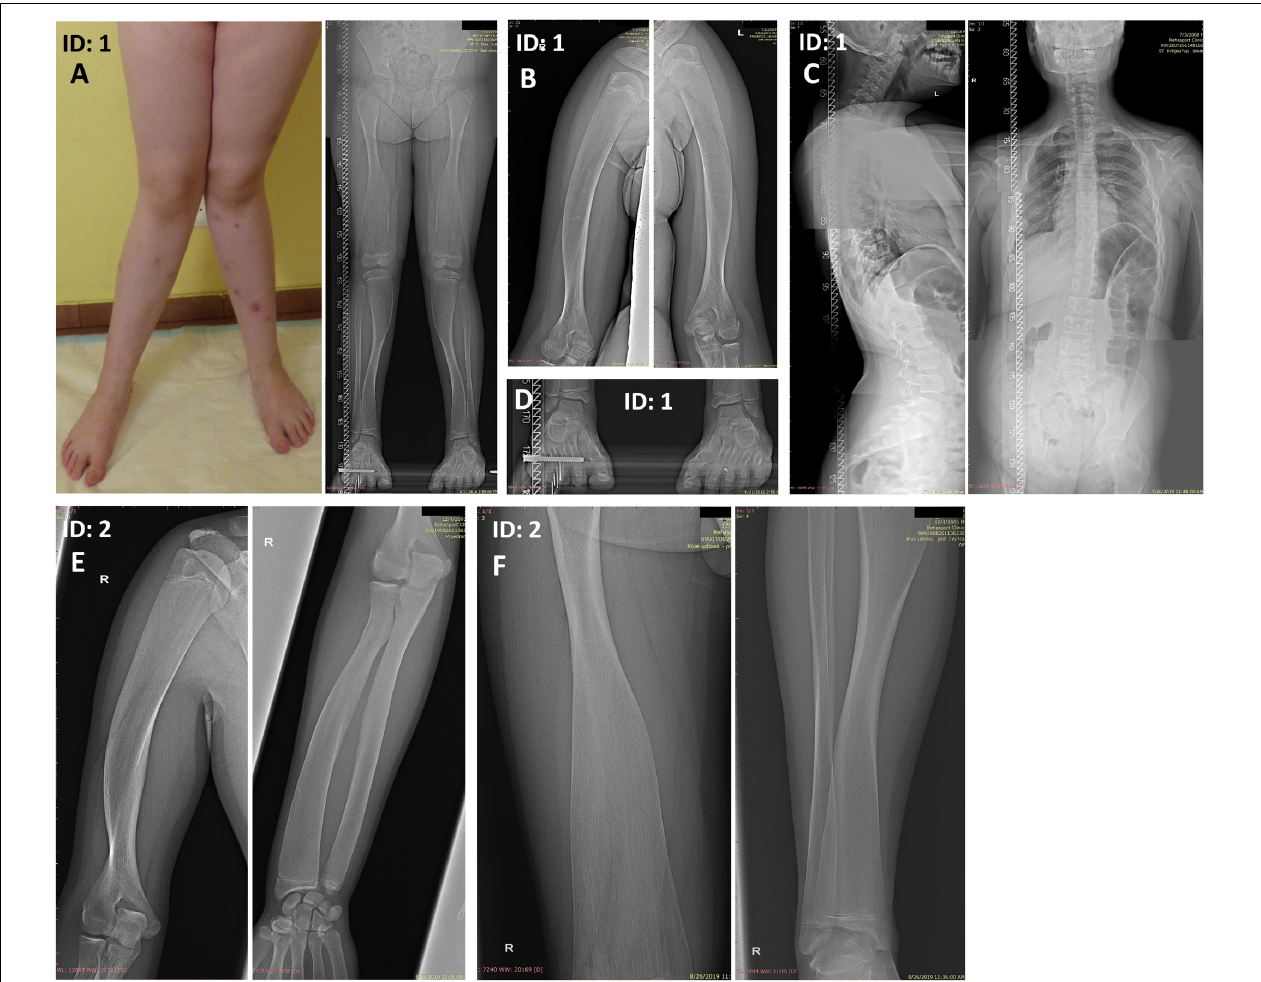
FIGURE 1 | Skeletal malformations observed in the female proband (A–D) and her brother (E,F) . (A) bilateral genua valga with a severe broadening of the knee joints. (A,F) Radiographs of the legs showing wide metaphyses and thin cortex of the femoral and tibial bones. (B,E) Radiographs of the upper extremities showing broadening of the proximal two-thirds of the humeri and the distal portion of the radial bone. The inward deviation of the distal one-third of the humeri was also noted (E) . (C) Radiographs of the spine showing thoracolumbar scoliosis. (D) Radiograph of the feet showing broadened metatarsals. ID: 1, proband, ID: 2, affected sibling.